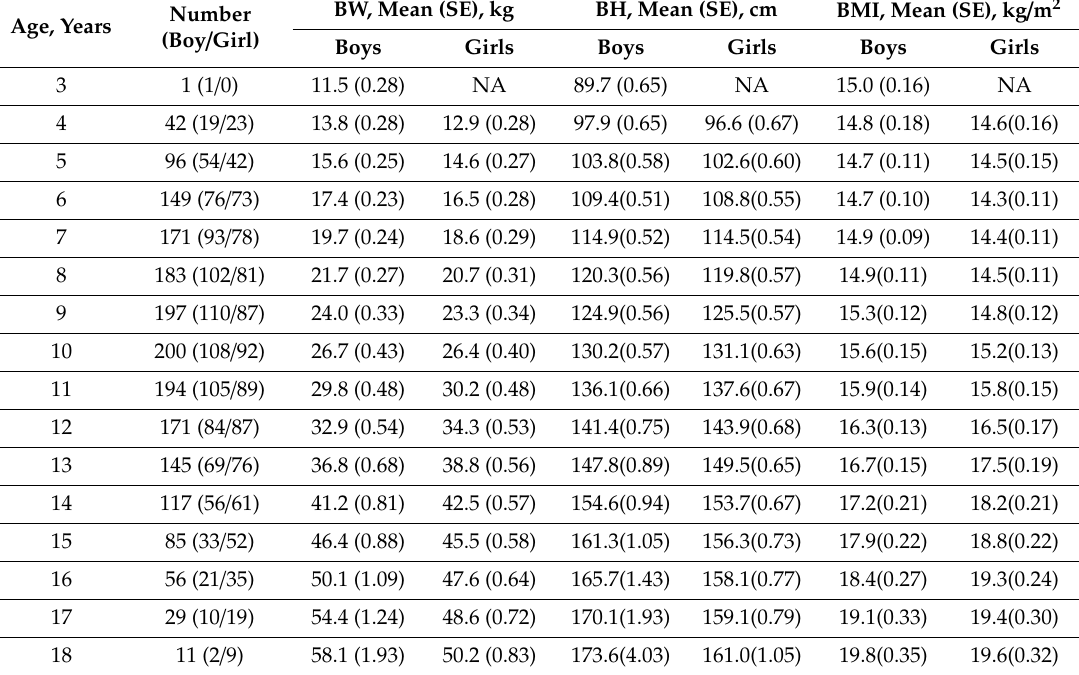
Table 2. Body weight, body height, and body mass index of participants stratified by age and